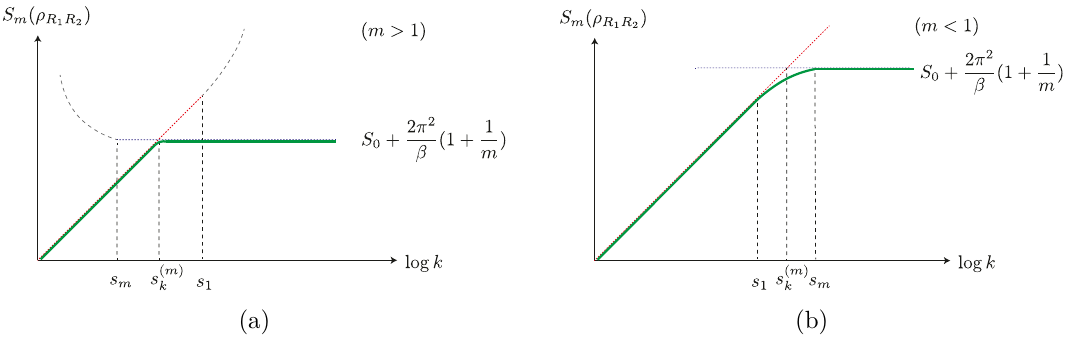
Figure 5 . (a) For m > 1 , the Renyi entropy (denoted by the green line) has a sharp transition at s k = s ( m ) where the two replica symmetric saddle contributions (denoted by blue and red dotted k lines) exchange dominance. Phase transitions in the two terms in eq. (3.19) happen at s k = s 1 , s m (depicted with curved, gray dashed lines) and thus don’t affect the Renyi entropies. (b) For m < 1 , the Renyi entropy (denoted by the green line) has a transition in the range s k ∈ [ s 1 , s m ] whereas the two naive replica symmetric saddles (denoted by blue and red dotted lines) exchange dominance at s k = s ( m ) . Thus, the phase transition is over a large window of size O k (cid:16) (cid:17) 1 has O corrections compared to a naive analytic continuation of the replica symmetric saddles. β m = 1